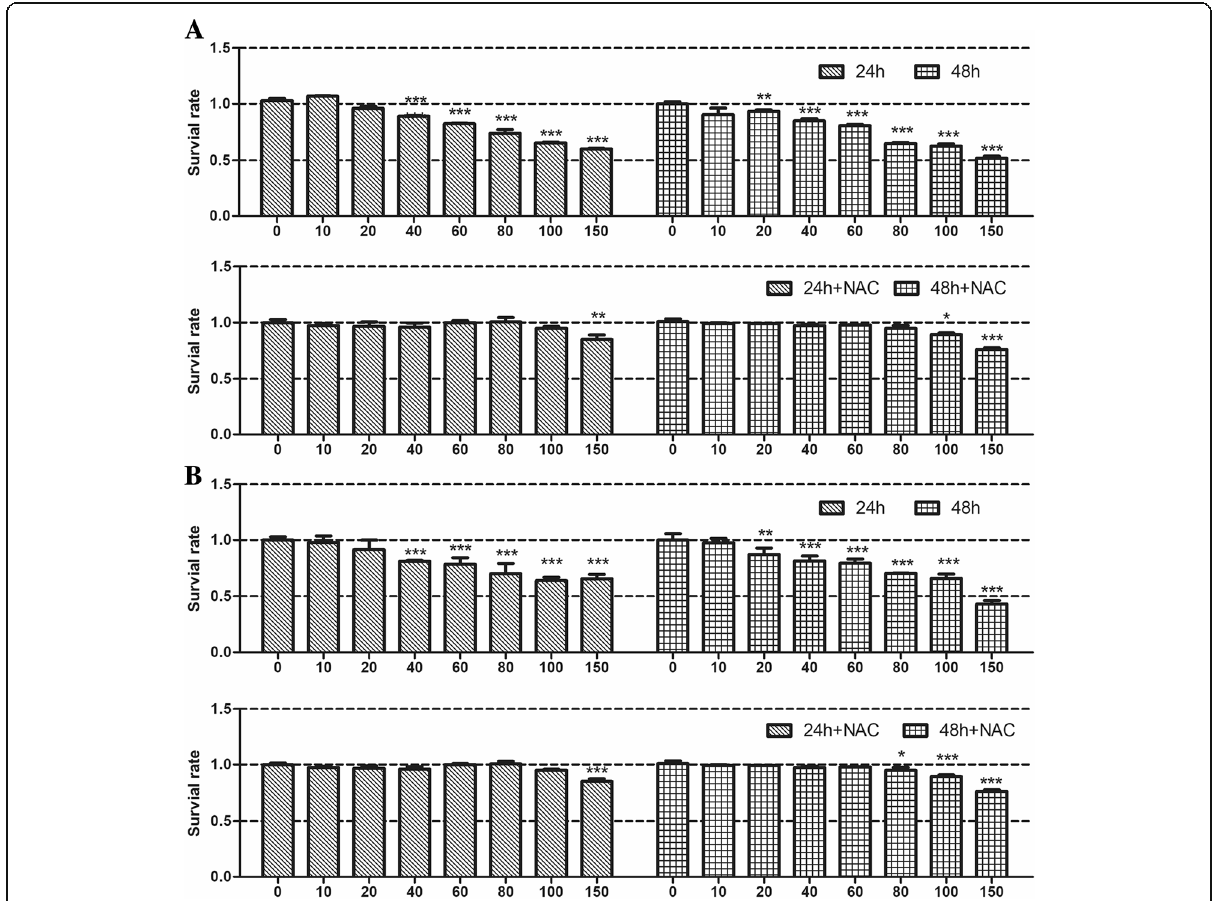
Fig. 2 TiO 2 and ZrO 2 NP-induced cell viability decrease in 3T3-E1 cells. 3T3-E1 cells were treated with TiO 2 ( a ) and ZrO 2 ( b ) NPs at concentrations of 0, 10, 20, 40, 60, 80, 100, and 150 μ g/mL for 24 and 48 h, and then the cell viability was detected via the CCK-8 assay. Meanwhile, the cell viability changes were detected after NAC treatment, which could eliminate intracellular ROS. The results represent the means ± SEM. * p < 0.05; ** p < 0.01; *** p < 0.001, compared with the